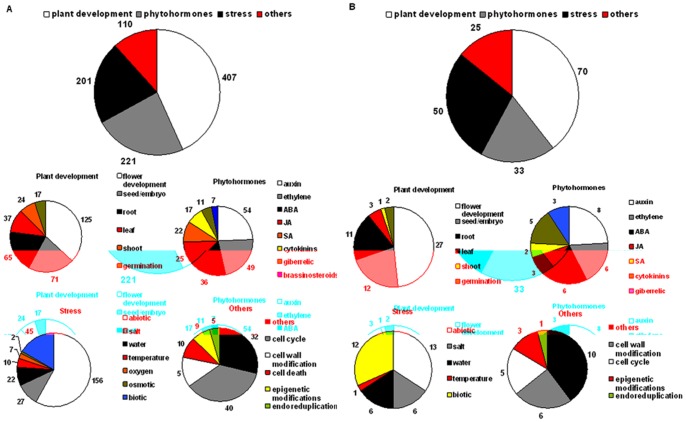
Functional categories of differentially expressed genes.A) TFs differentially expressed during SE. B) SE-associated TFs. TFs were annotated to four major categories (plant development, phytohormones, stress and others) and various subcategories. Given are the numbers of TFs in the different functional categories.